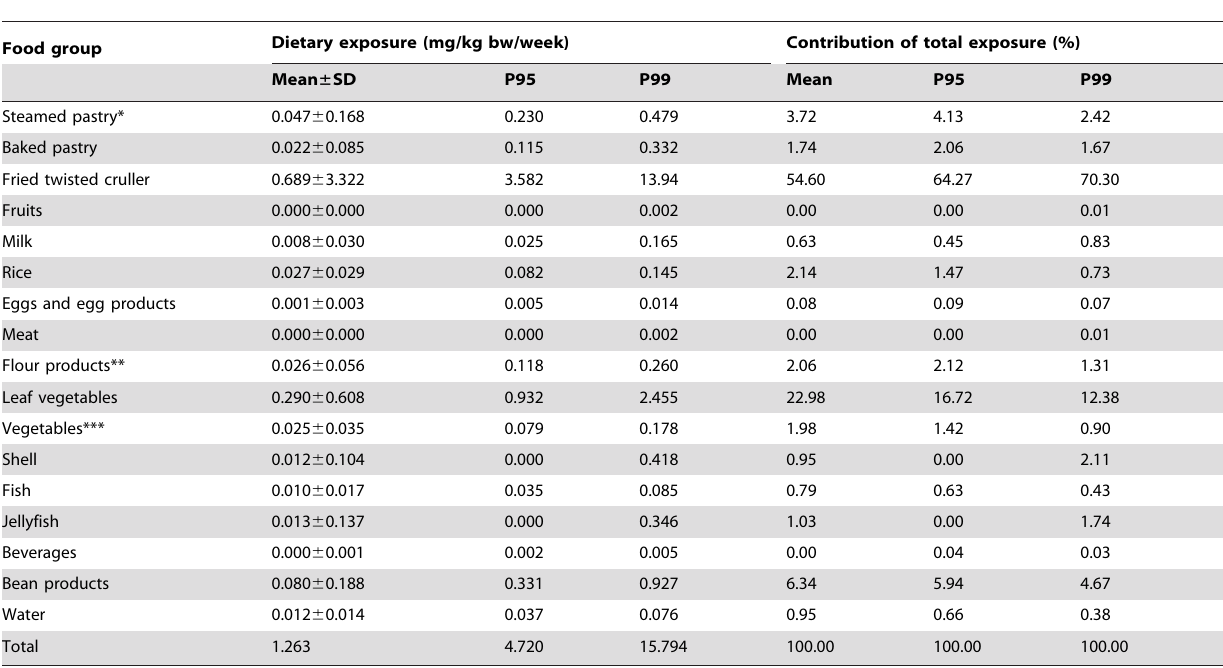
Table 4. Estimated dietary Aluminum exposures in a week (mean, 95th and 99th percentiles) of the Shenzhen